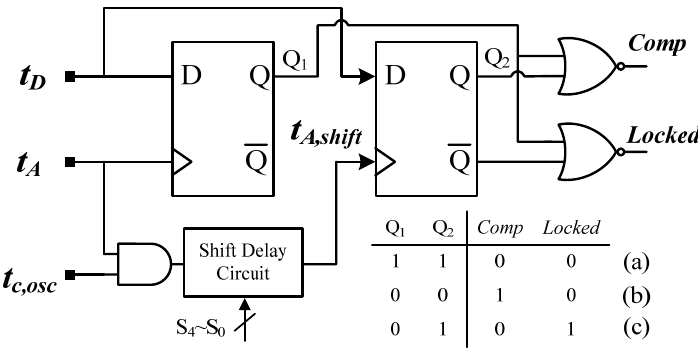
Figure 10. Schematic of time